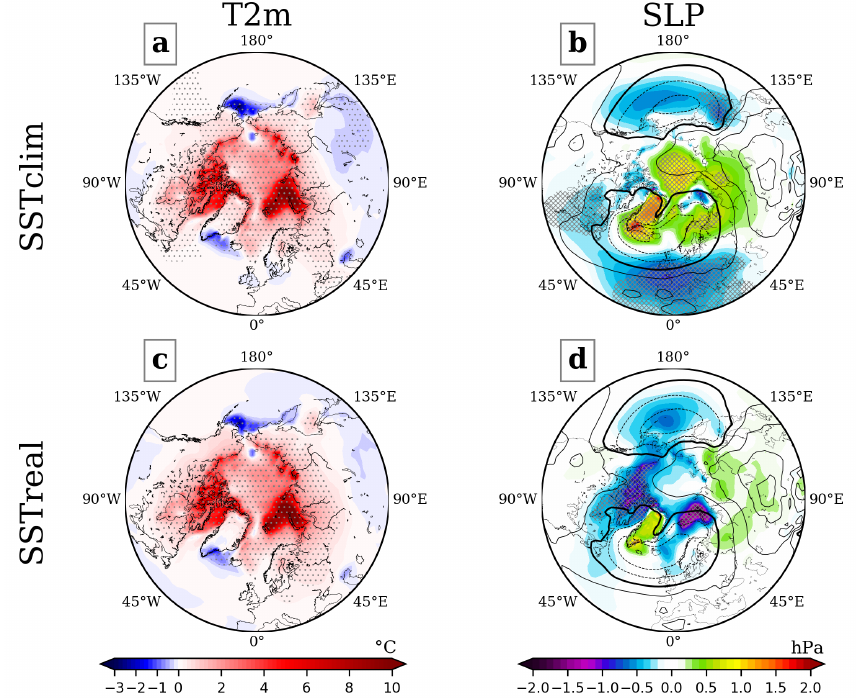
Figure 2. Winter ensemble-mean responses (experiment minus control) in the lower atmosphere. Two-meter air temperature (T2m) ( a , c ); sea-level pressure (SLP) ( b , d ). Results are given for the SSTclim and SSTreal cases. The black contours in the SLP plots show the corresponding climatological values from the control ensemble (the bold line is the 1015 hPa isobar; values greater/less than 1015 hPa are shown with continuous/dashed lines and the contour interval is 5 hPa). Dotted (T2m) and hatched (SLP) areas indicate regions where the differences are statistically significant at the 95% confidence